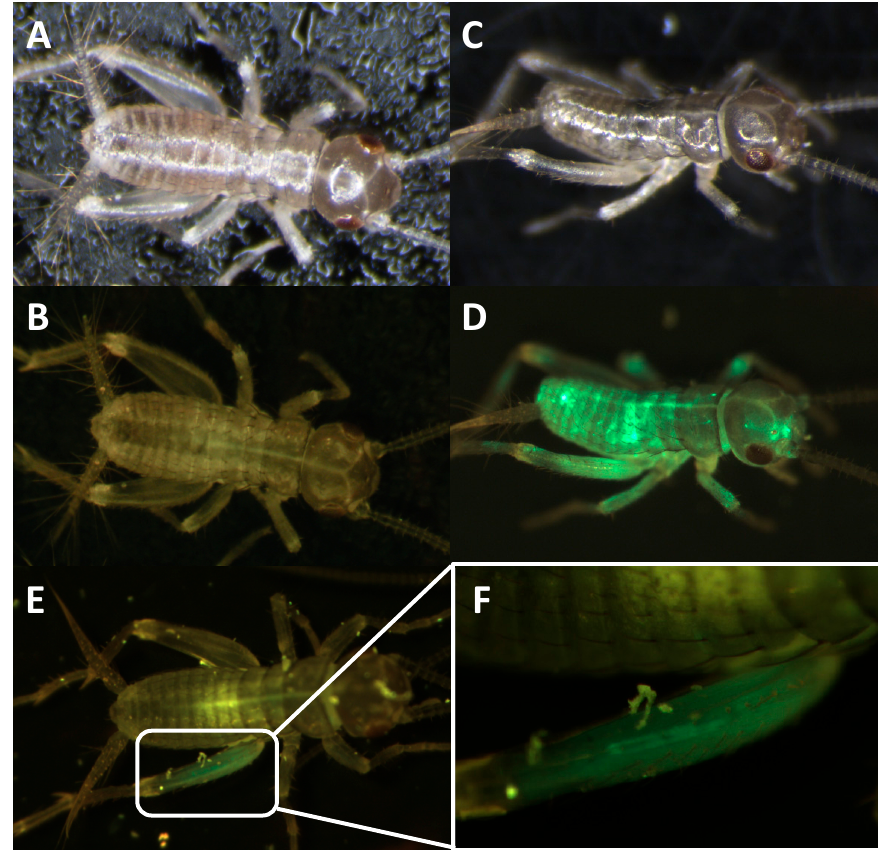
Figure 8. Somatic knock-in EGFP in A. domesticus by CRISPR/Cas9. Wild-type cricket under white light ( A ) and florescent light with GFP filter ( B ). Successful knock-in cricket with large area of somatic knock-in under white light ( C ) and florescent light with GFP filter ( D ). Cricket with small area GFP knock-in phenotype, ( E ) and enlarged picture of muscle structure GFP expression ( F ).